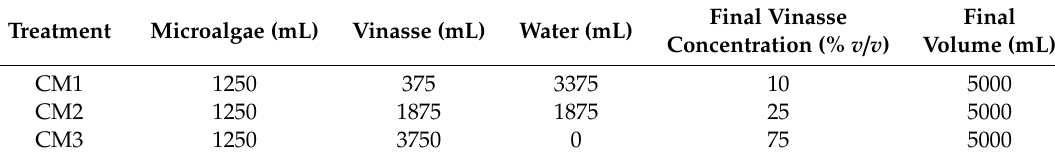
Table 1. Culture media composition.